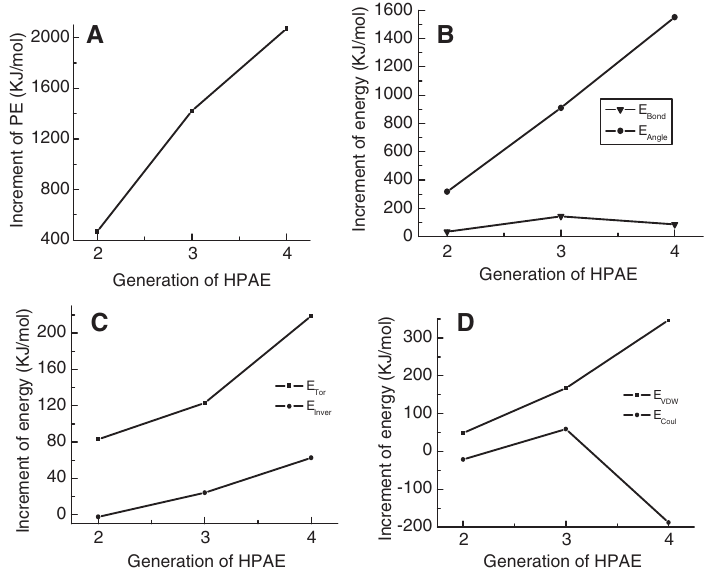
Figure 6 Amplification pictures of HPAE/Nd energy curves with the generation relationship.